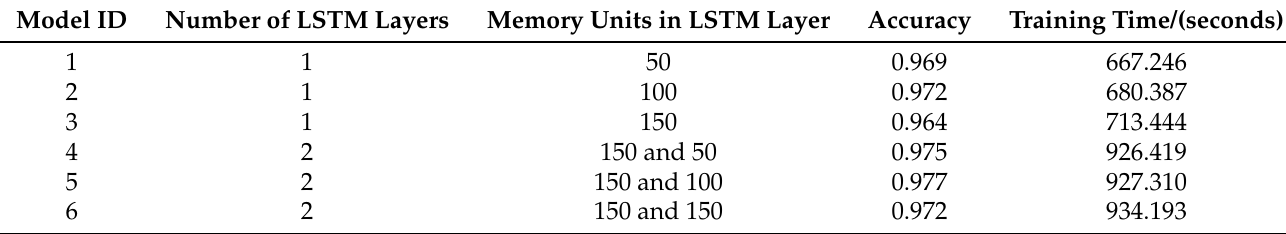
Figure 13. ROC curves, FRR curves and EER curves. ( a ) is the FRR curves and FAR curves ( b ) is the ROC curves and EER curves. Table 7. Precision results of different neural